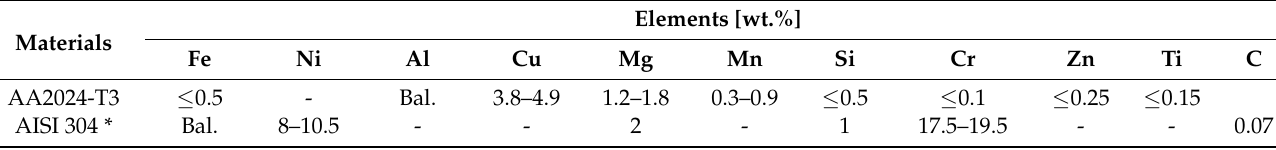
Table 1. Chemical compositions of used materials.